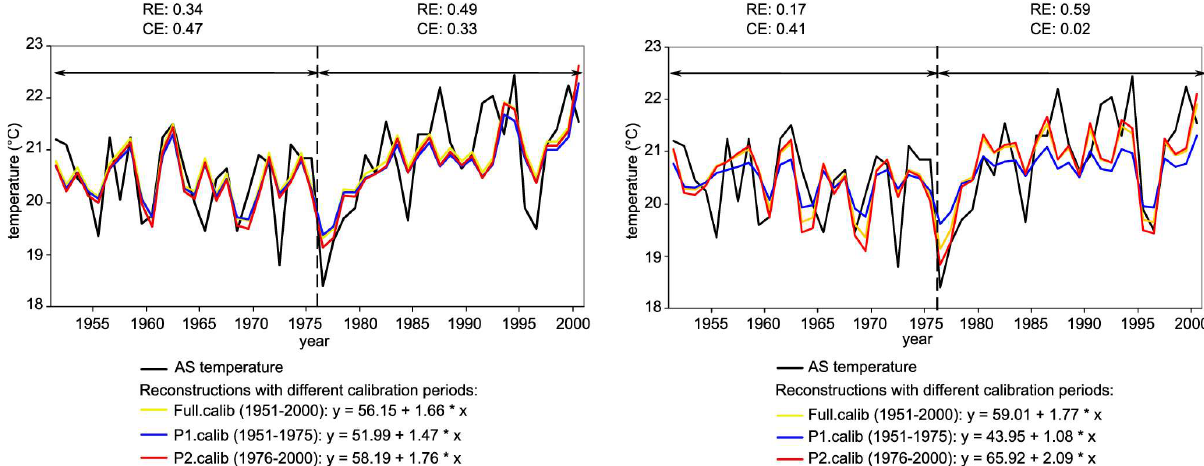
Fig. 3. Split calibration-verification scheme of the two August/September temperature reconstructions: reconstruction based on FE-corrected Asinao chronology (left panel), reconstruction based on pin-corrected mean chronology Asinao-Ballone (right panel). The climate data set is devided in two equal time periods P1 and P2 for calibration and verification, respectively. RE: reduction of error; CE: coefficient of efficiency.